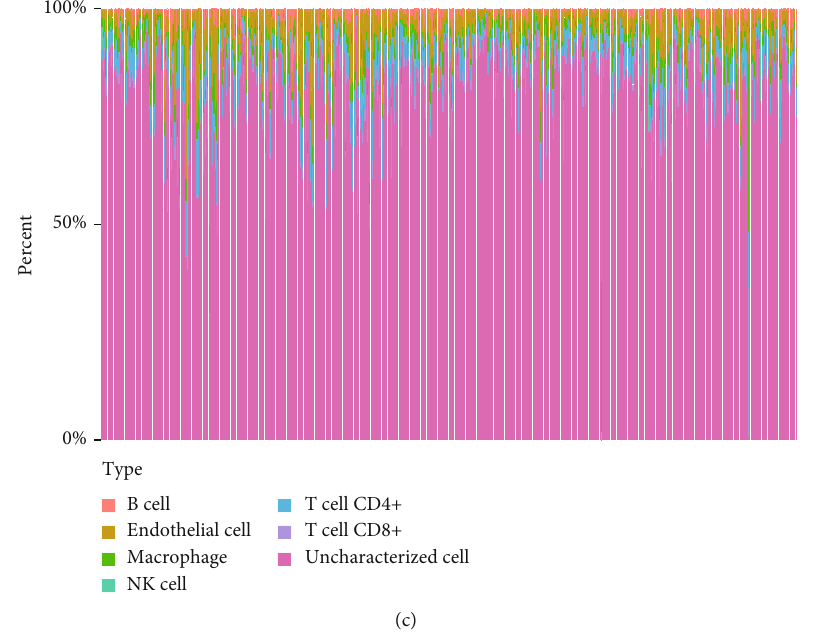
Figure 8: (a, b) The expressing feature of immune cells in LUAD specimens and nontumor specimens. ∗∗∗ p < 0 : 001and ∗∗ p < 0 : 01